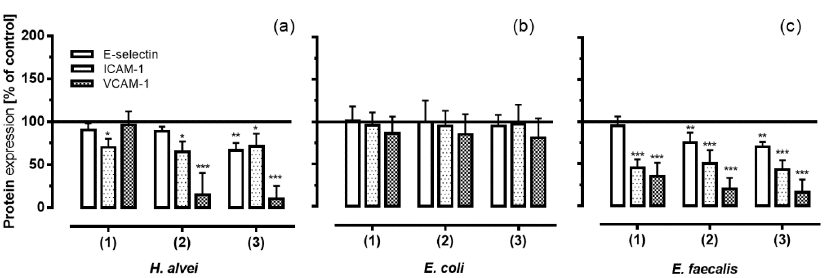
Figure 4. Expression of the adhesion molecules E-selectin, ICAM-1 and VCAM-1 on HUVECs under low-grade inflammation (LGI) and long-term incubation conditions fermented by ( a ) H. alvei ; ( b ) E. coli and ( c ) E. faecalis . After incubation of Caco-2 cells with fermented ACNs from the lag- (1), log- (2) and stat-phase (3), transwell inserts were removed, and the co-cultured HUVECs were used after 20 h. Thereafter, cells were stimulated for 3 h using 1 ng/mL TNF- α (LGI). After TNF- α stimulation, protein expression (MFI, main fluorescence intensity) was measured as described in the Materials and Methods section. Corresponding controls (maximal expression of cell adhesion molecules after LGI) were set as 100%. Values are given as the mean ± SD ( n = 3). Differences were significant at * p < 0.05, ** p < 0.01 and *** p < 0.001.